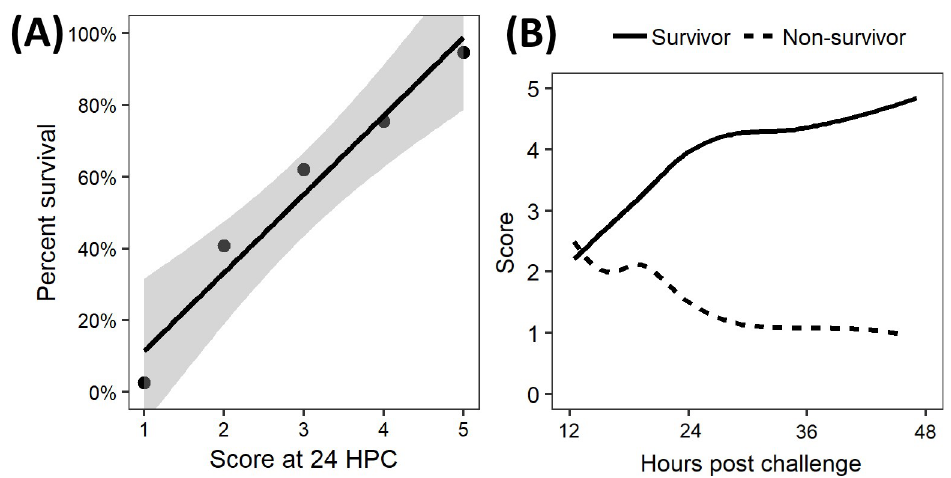
Fig 2. Health scores were directly associated with outcome in a polymicrobial model of sepsis in neonatal mice. (A) Scores recorded at 24 hours post challenge (HPC) plotted against the percent of mice which survived the IP cecal slurry challenge. Scores of zero were excluded as they were the pre-determined humane endpoint. A significant linear regression was found (R 2 = 0.946, p = 0.0035, n = 210) with mean percent survival increasing by 22 ± 8% for each single point increase in score. Shaded area represents standard error. (B) Visual representation of change in score defined numerically over time following IP cecal slurry challenge.